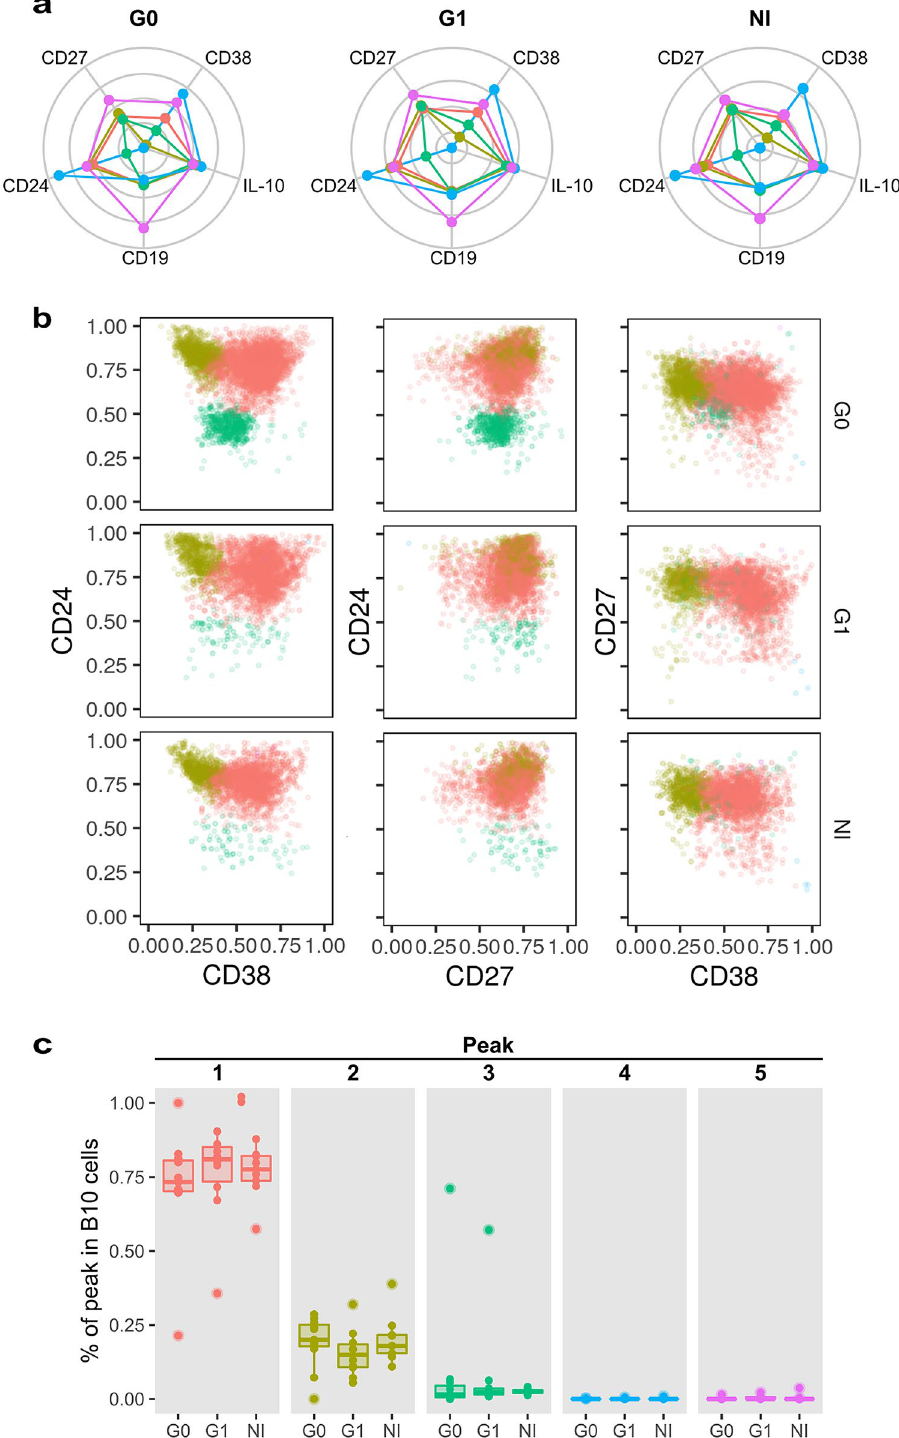
Figure 7. Automatic gating performed by flowPeaks algorithm of B10 cell subsets based on CD19, CD24, CD27 and CD38 expression. ( a ) Spider plots display the median expression for each marker in the different peaks. ( b ) Representative biaxial dot plots showing the distribution of peaks within B10 cells based on CD24–CD38, CD24–CD27 and CD27–CD38 expression. ( c ) Box plots showing the percentage of cells within each peak in B10 cells in G0, G1 and NI